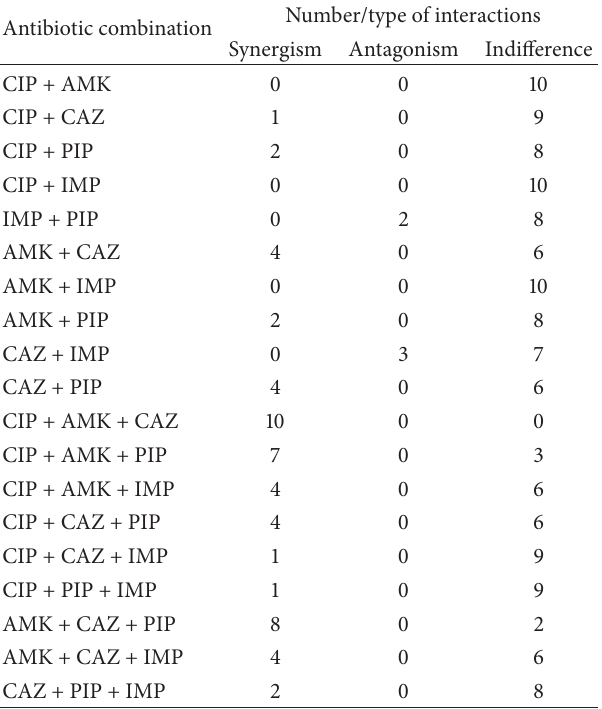
Table 5: Summary of the outcome of double and triple combina- tions of the